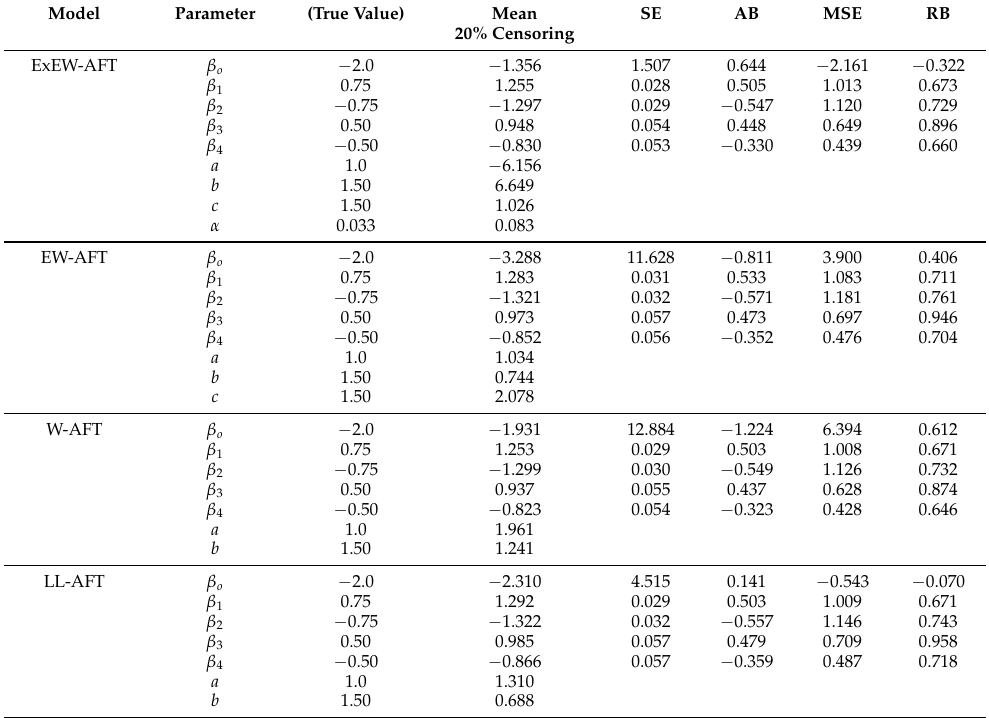
Table 2. Simulation study for scenario 1 ( n = 5000) with about 20% censored observations is used to compare model